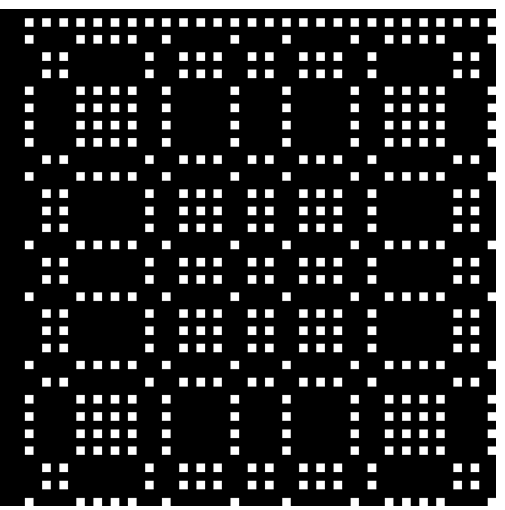
Figure 2. Single MURA array, with sequence length of 29. The white squares are fabricated as holes in the 5 µm thick gold.